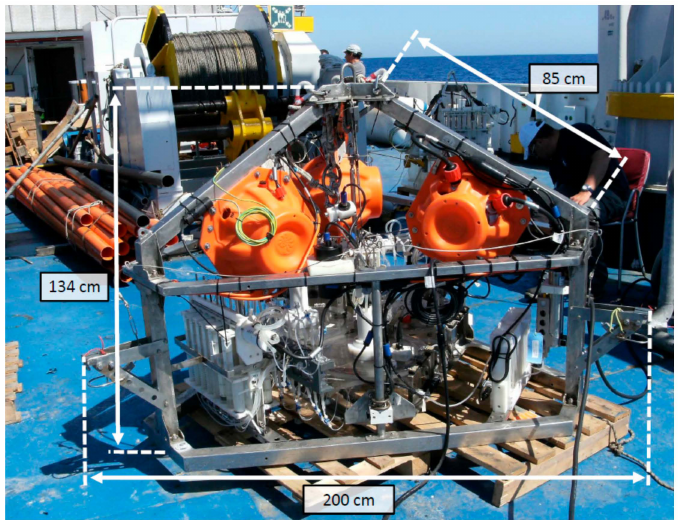
Figure 1. Photograph of the Amerigo Lander showing the tripod structure, the measurements, and the main instrumentation and